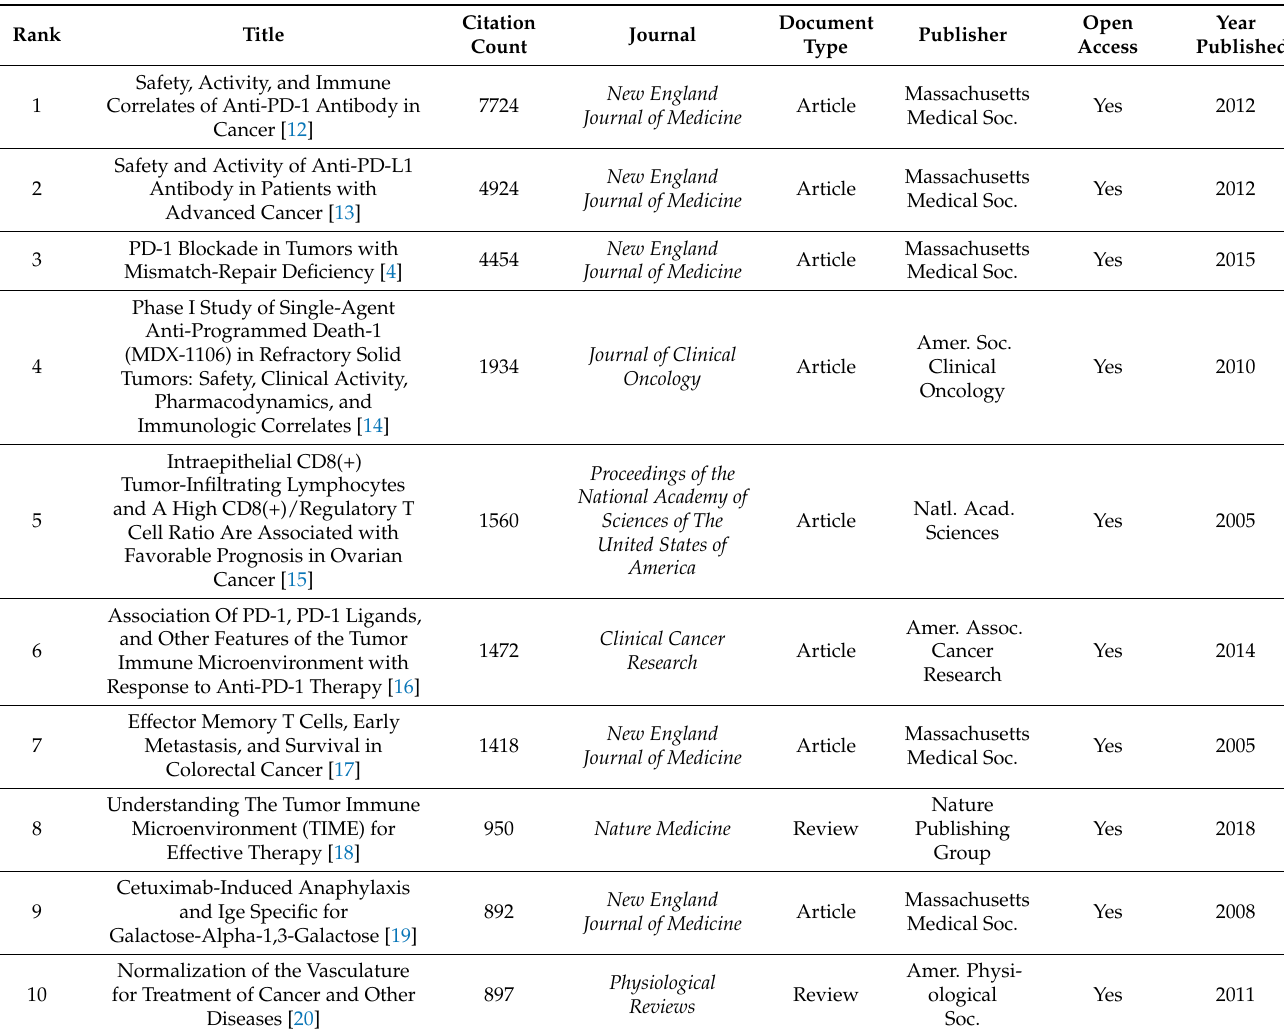
Table 3. Top 10 highly cited papers related to immunotherapy in colorectal cancer according to the Web of Science